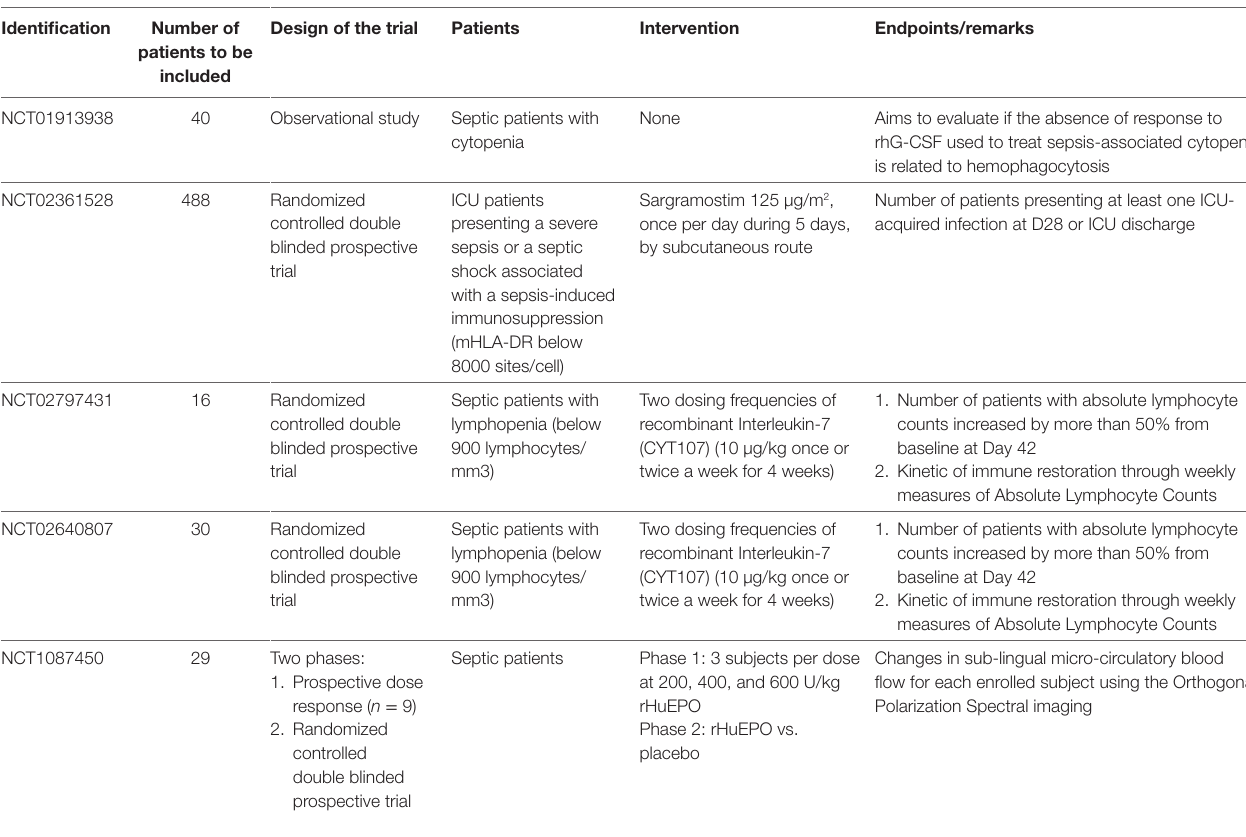
TAbLe 1 | Ongoing trials on the use of hematopoietic growing factors during sepsis.